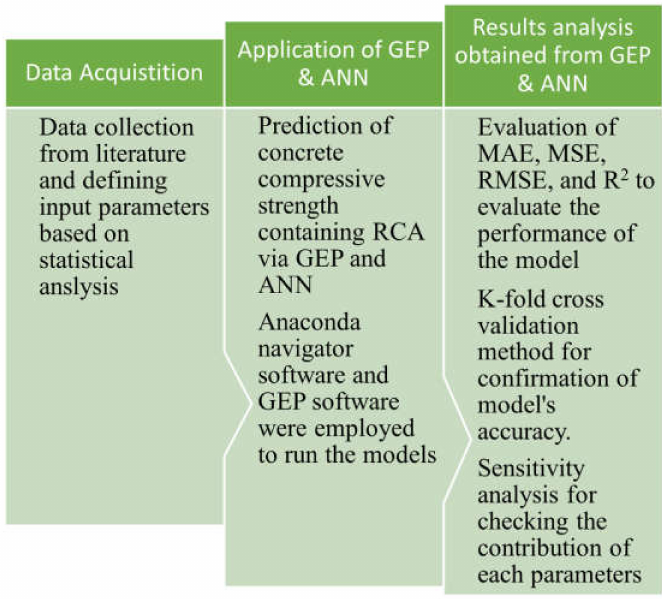
Figure 2. Flowchart of the research